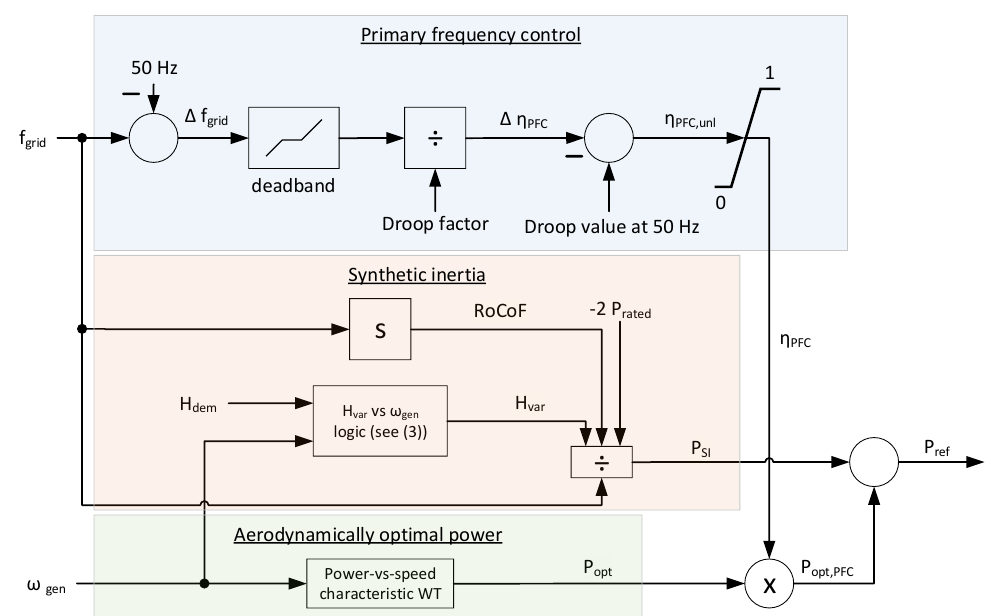
Figure 3. Block diagram of the power reference for the WT including grid frequency support (primary frequency control (PFC) and synthetic inertia (SI)).